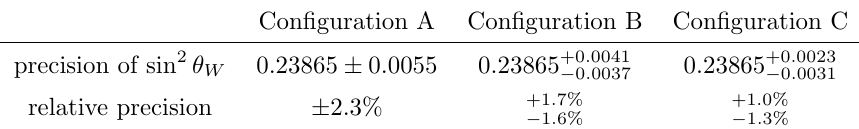
Figure 2 . Measurement of sin 2 θ at different energy scales ( µ ). The red error bars represent the W precision of LXe-A, LXe-B, and LXe-C expected from this work. The other measurements are from figure 10.2 of the PDG [60]. Measurements from earlier neutrino elastic scattering experiments do not have sufficient precision to be included in this plot.